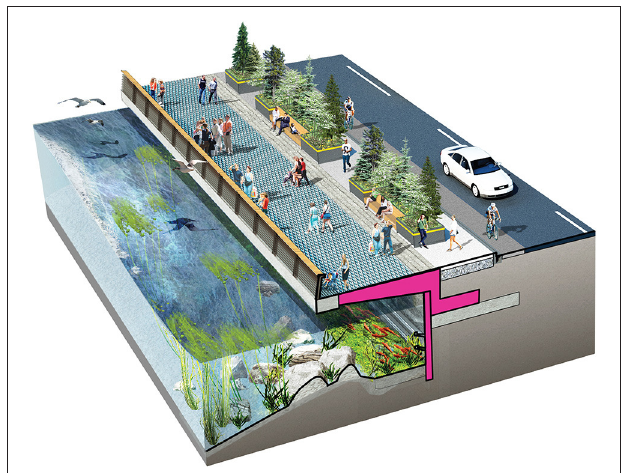
FIGURE 7 | The Elliott Bay Seawall is an example of a Research Partnership Informing Design project. It includes an elevated seafloor and bench re-established a long-interrupted salmon migration route. The light penetration and water depth conditions mimic a natural shoreline and provide a refuge from predation. The precast concrete seawall face panels and habitat shelves and cantilevered light-penetrating system panels support the salmon migratory path. Overall, the restoration activities have increased substrate complexity and epibenthic invertebrate taxa richness. The project team for the seawall includes WSP (formerly Parsons) (Prime Firm, Program Manager, Design Manager, Permitting, Environmental Documentation, Procurement, Utilities Engineering, Geotechnical Engineering, Landscape Architecture, and Structural Engineering), Magnusson Klemencic Associates (Lead Engineer for Public Realm and Habitat Design Integration), Perteet and SvR (Civil and Drainage Engineering), Moffatt and Nichol (Coastal Engineering), COWI